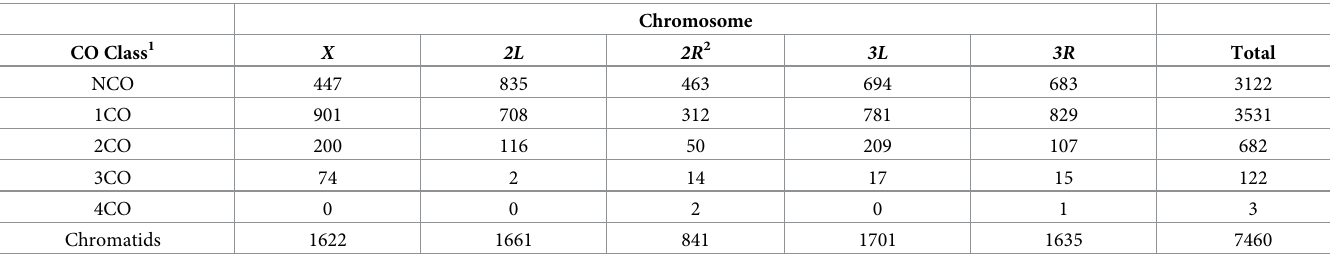
Table 1. Observed number of meiotic events in D . yakuba .